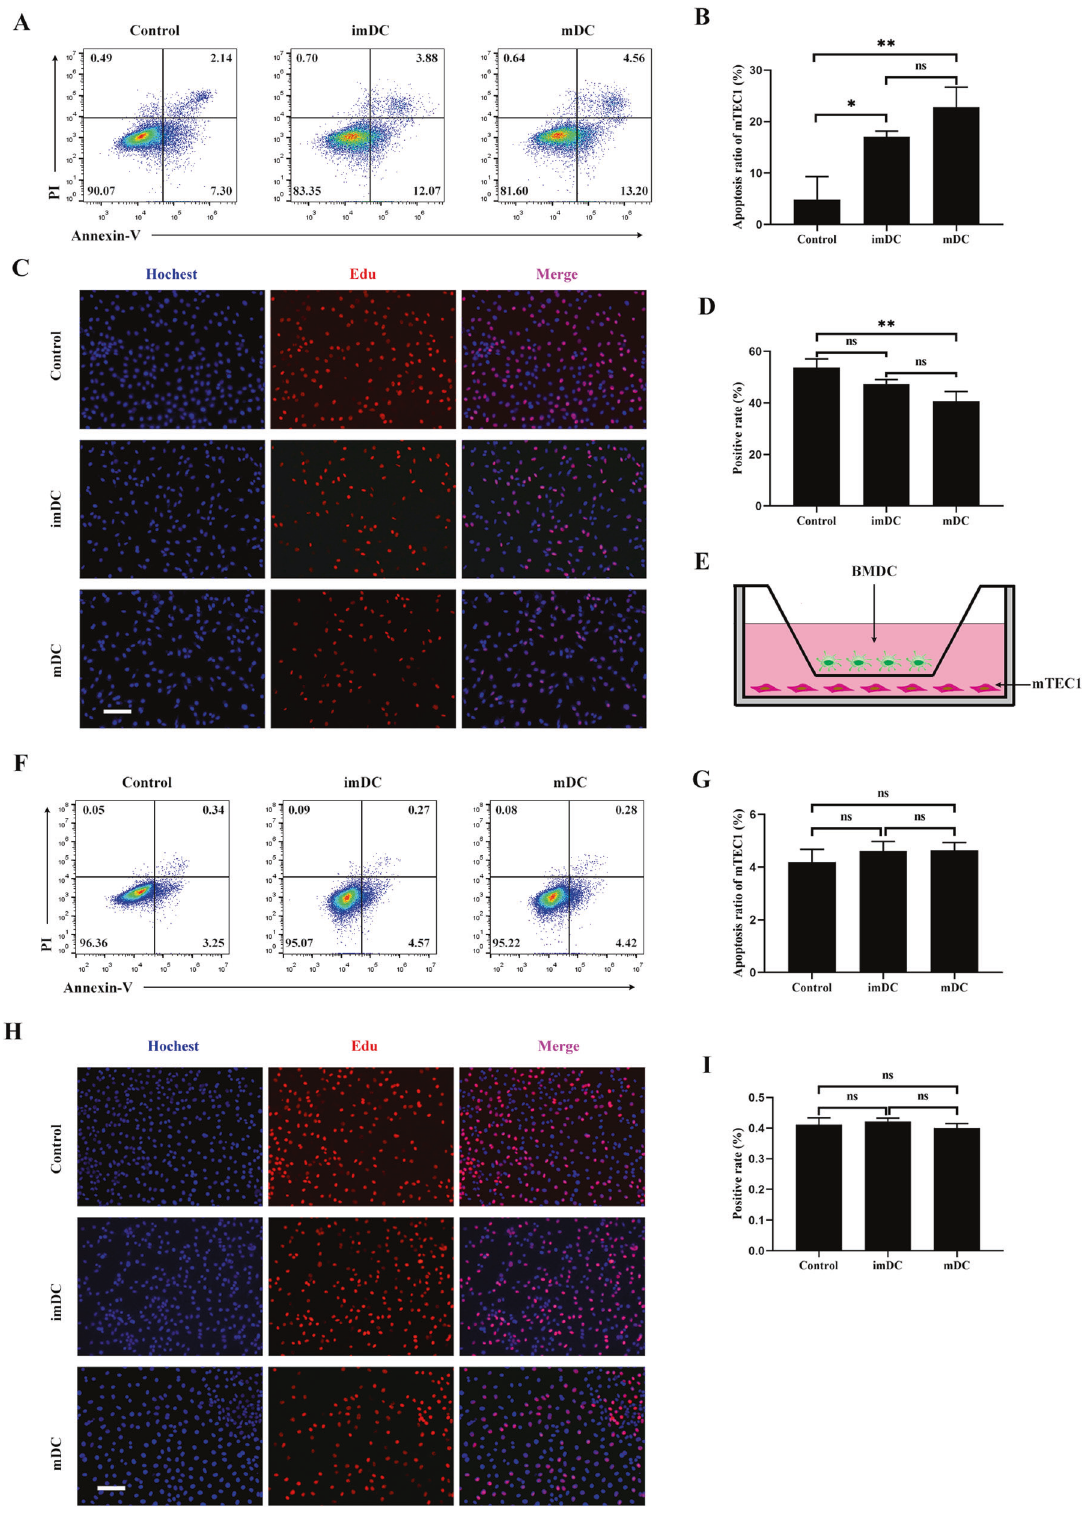
MDCs induced apoptosis and inhibited proliferation of mTEC1 cells by activating Notch signaling To determine whether Notch signaling played a critical role in thymic involution, mTEC1 cells were boosted with coating rmJagged1-hFc to activate Notch signaling. The results